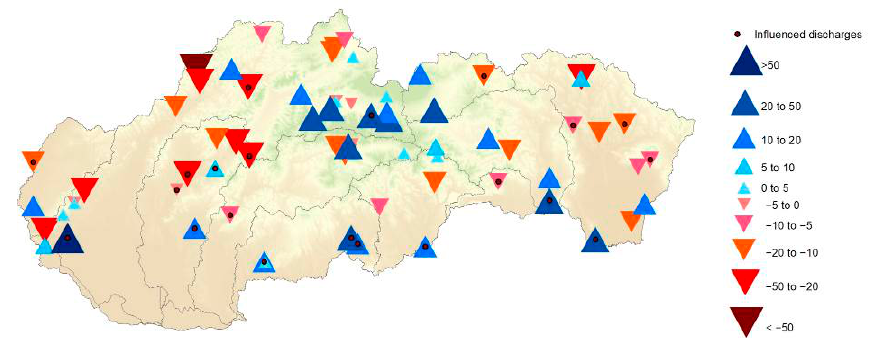
Figure 4. Changes in values of Q 355d from 2001–2015 vs. 1961–2000 (% of increase/decrease).